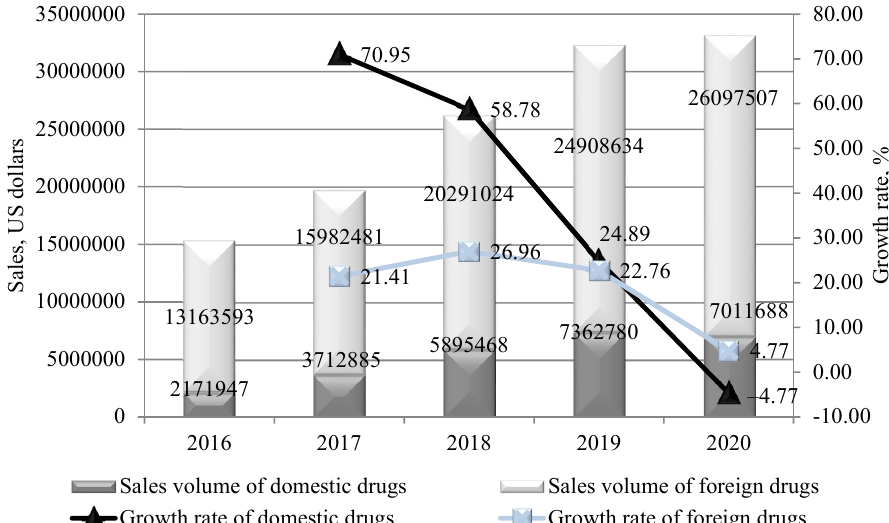
Fig. 3. Dynamics of indicators of retail sales of antiepileptics in cash for the pharmaceutical market of Ukraine